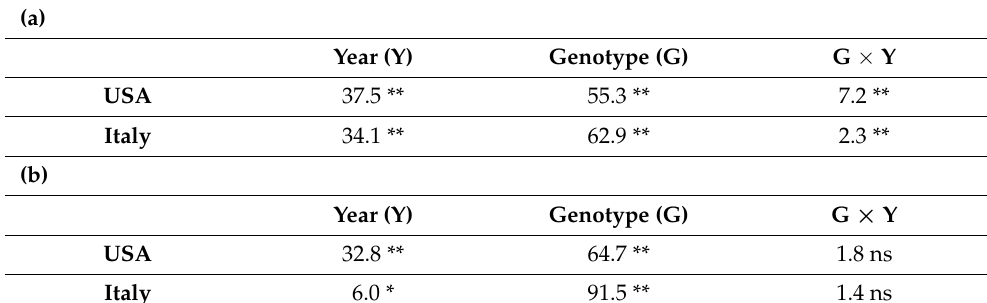
Table 4. Analysis of variance: percentage of mean square obtained from the ANOVA highlighting the contribution of genotype and crop year and their interaction to the variability of